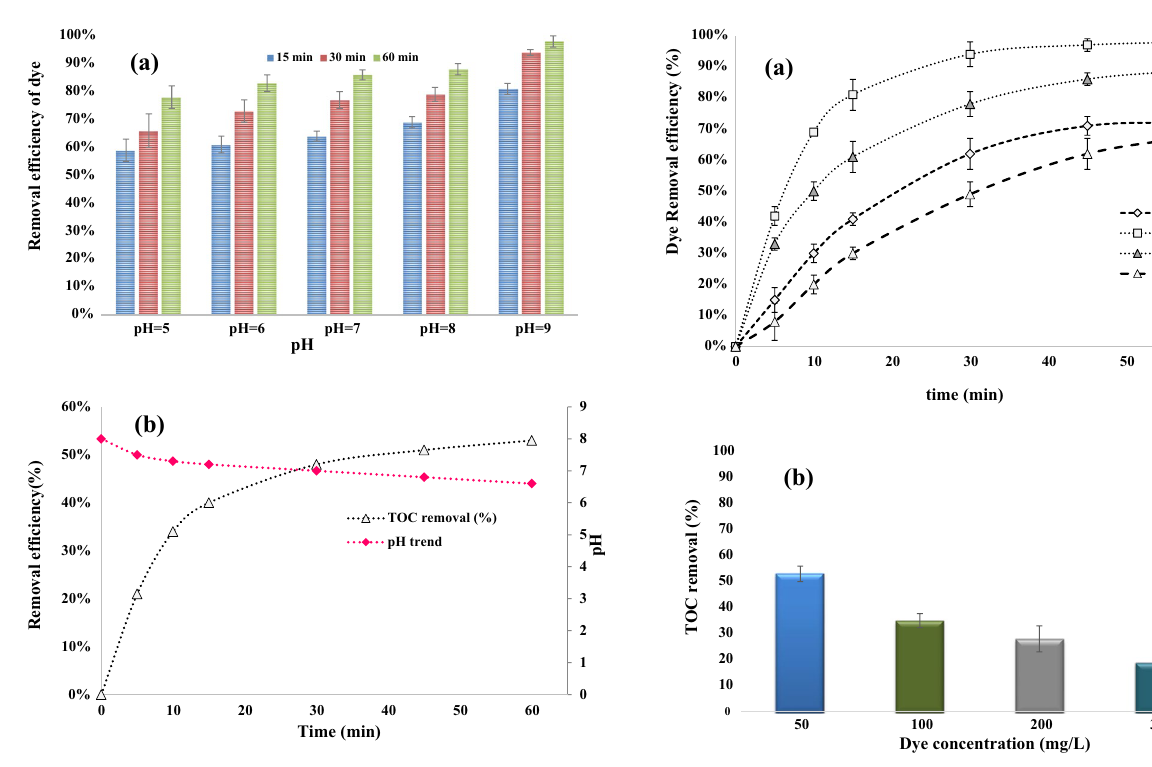
Fig. 3 Effect of the initial dye concentration on dye discoloration (2a) and TOC removal (2b) in the ozonation process at an initial pH of